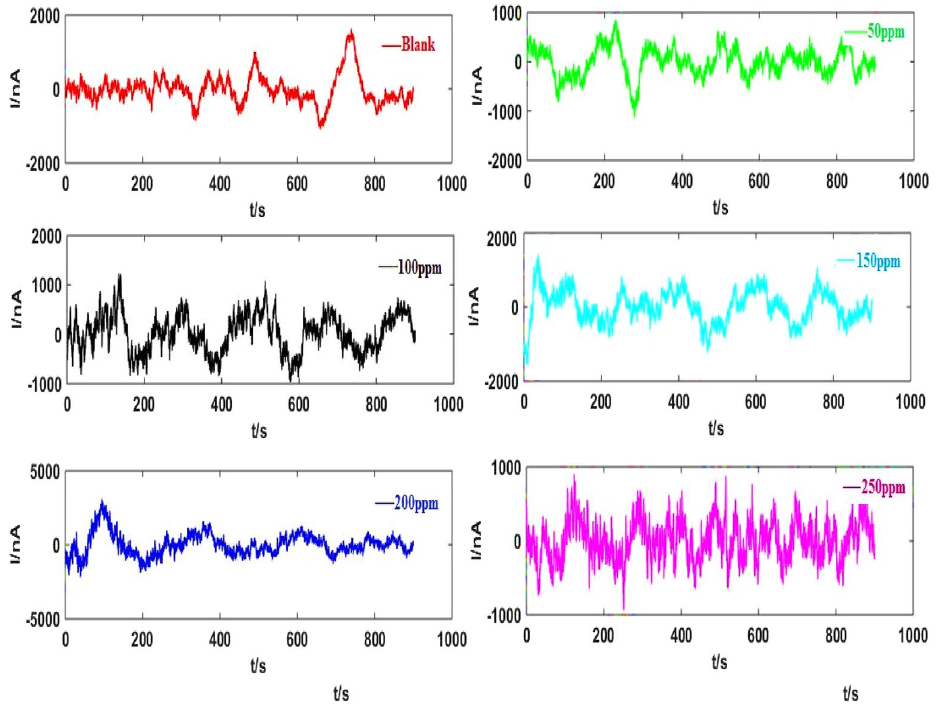
Figure 8. EN current records illustrated in Fig. 7, after elimination